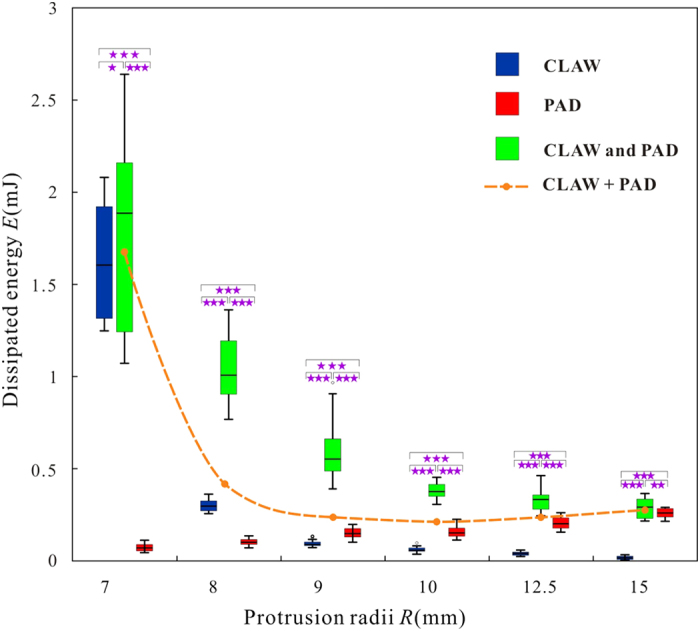
The dissipated energy of the claw, adhesive pad and combined device.Significance levels: *P > 0.05, **P < 0.05, ***P < 0.001.